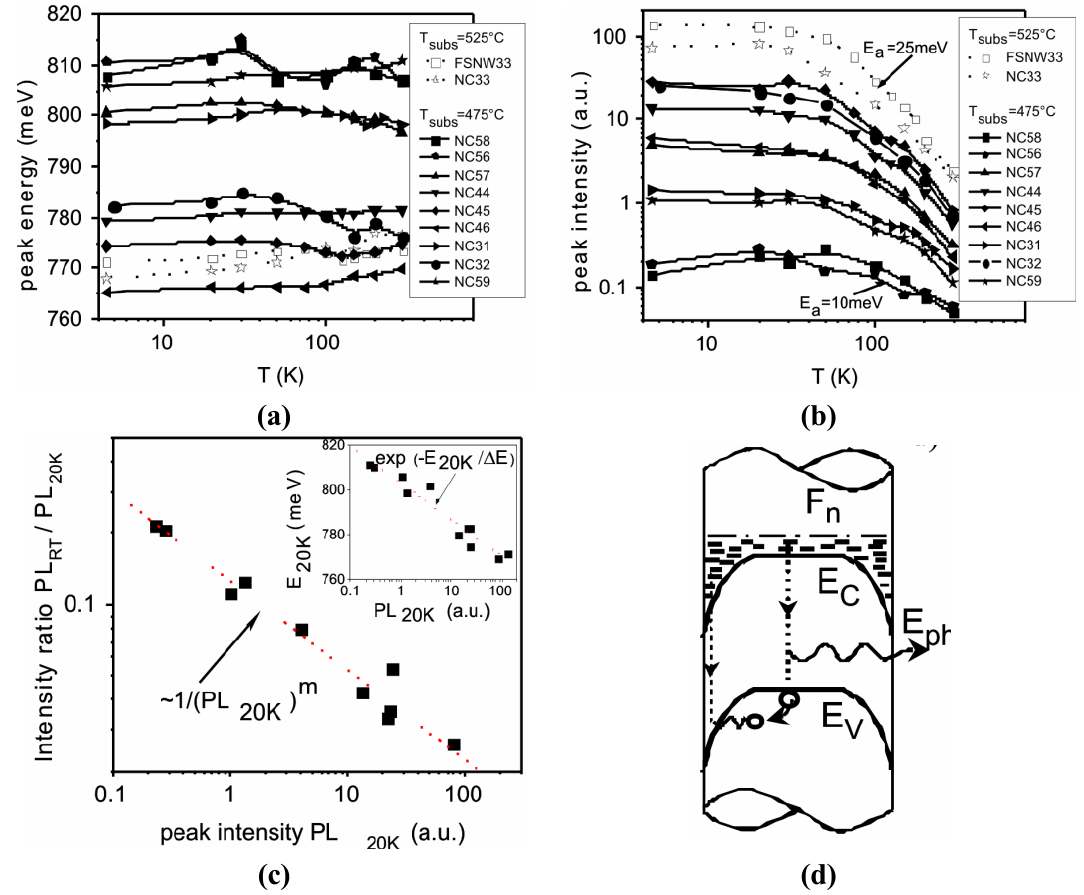
Figure 3. Photoluminescence (PL) Temperature dependence ( a ) peak energy; ( b ) peak intensity; ( c ) RT to 20 K peak intensity ratio vs. PL intensity at 20 K. Inset shows the correlation of peak energy to intensity at 20 K; ( d ) schematic band diagram that illustrates the carrier recombination within the accumulation layer of the lateral surface of the wires. With permission from